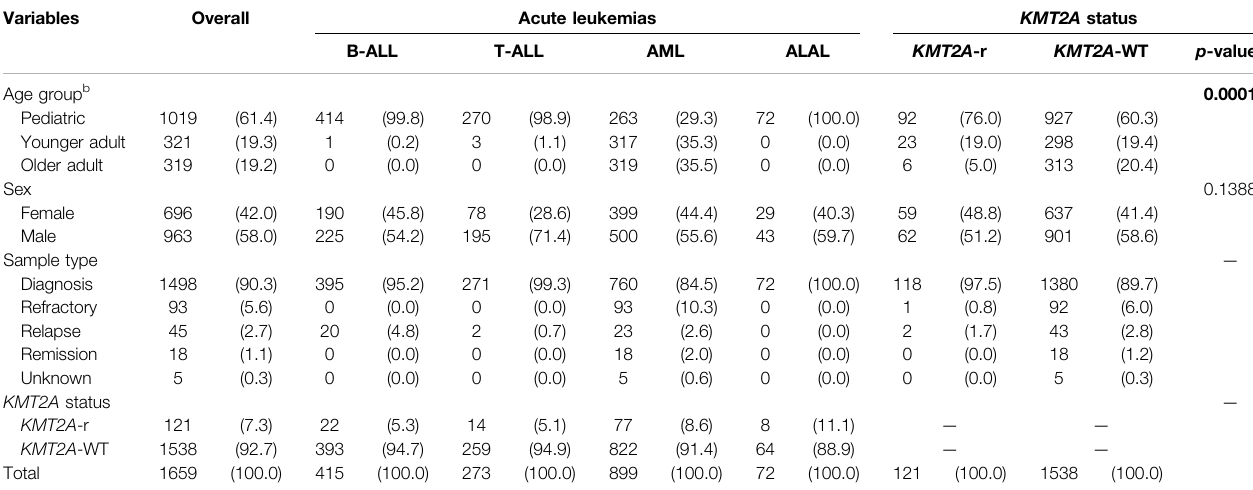
TABLE 1 | Cohort characterization.